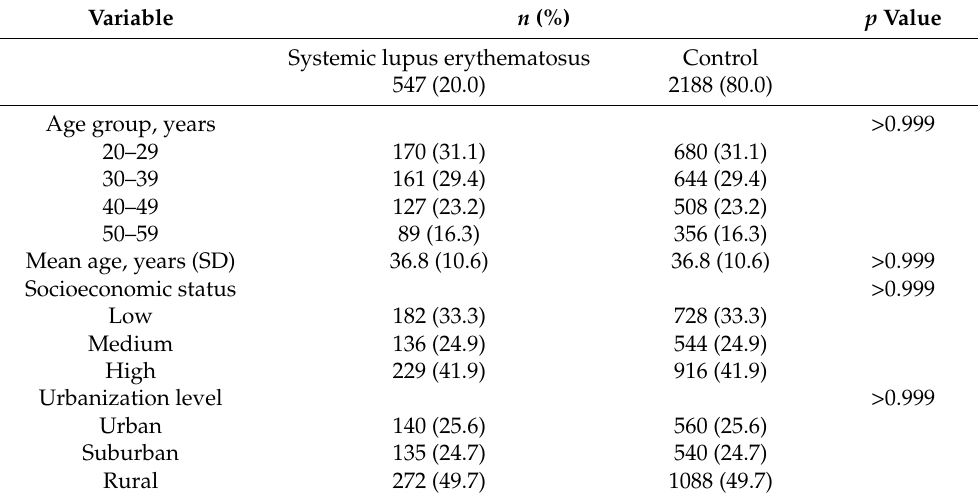
Table 1. Basic characteristics of patients with systemic lupus erythematosus and controls ( n = 2735). Variable n (%) p Value